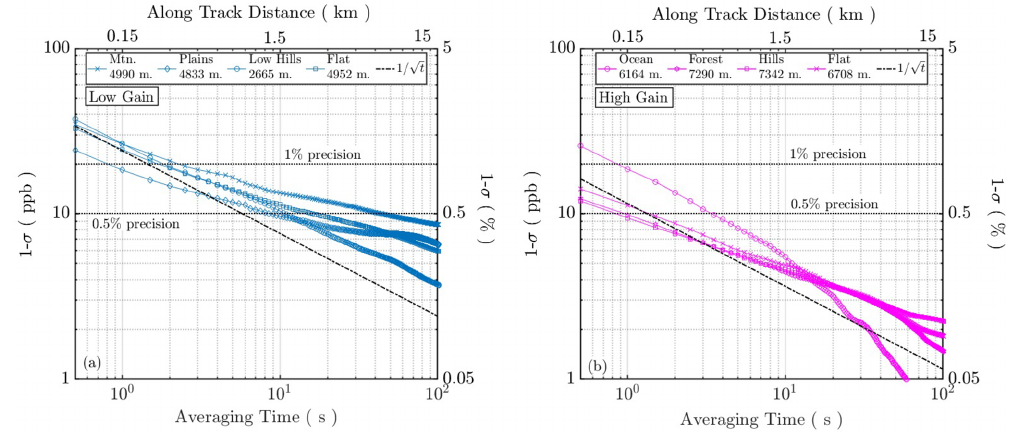
Figure 9. XCH 4 noise statistics from the low gain (a) and high gain (b) for different terrains. The XCH 4 measurement precision at the native 2Hz interval is ∼ 10–50ppb depending on terrain conditions and channel optimization. With a 15s averaging window, ∼ 2km along-track, measurements approach a < 10ppb precision, ∼ 0 . 5% assuming a 2000ppb background. The along track distance assumes a 150ms − 1 ground